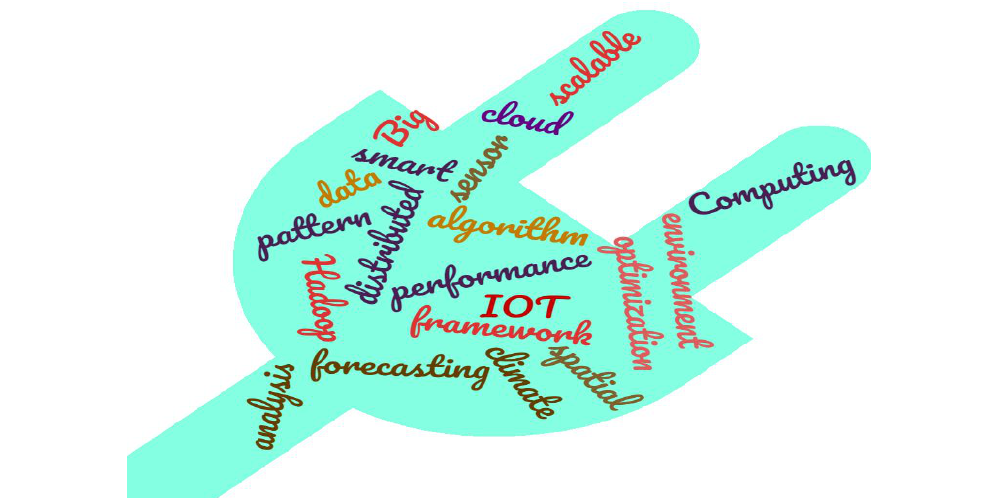
Figure 18. Word cloud for “Big Data and cloud computing: Innovation opportunities and